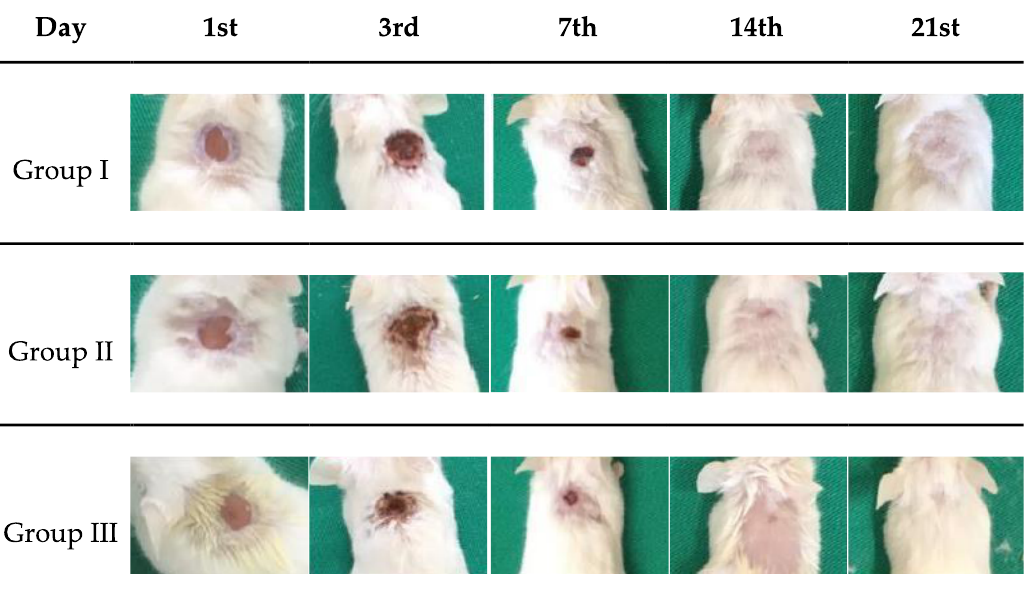
Figure 7. Macroscopic analysis of skin lesions in mice on 1st, 3rd, 7th, 14th, and 21st days of treatment with: Group I—physiological serum (PS); Group II—chicha hydrogel (GChi); and Group III—chicha hydrogel with 0.02 g mL − 1 nerolidol (GChiN2).